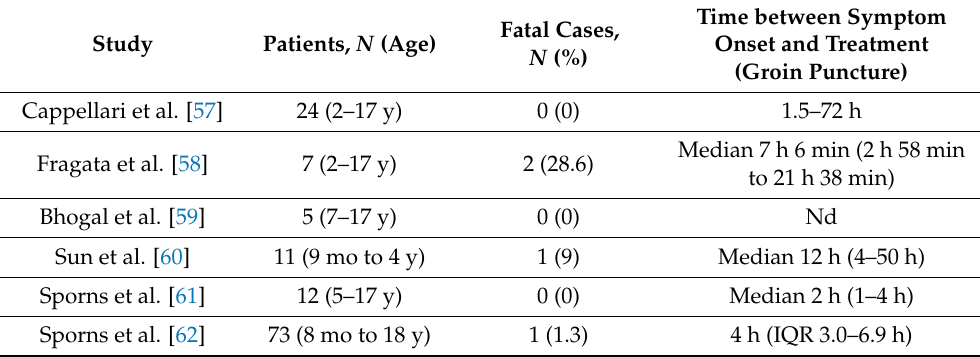
Table 5. Studies on thrombectomy in pediatric population: mortality